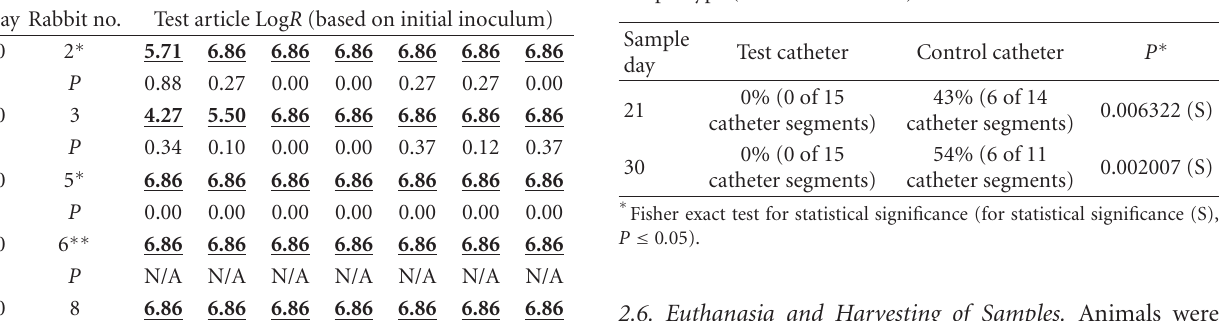
Table 7: Infection prevention on the catheter segments: the total number of samples where significant ( ≥ 3.0 Log) bacterial load was recovered (from sample locations 4, 6, 8, and 10) is divided by the total number of catheters/tracts in each group. This is separated by sample type (tissue and